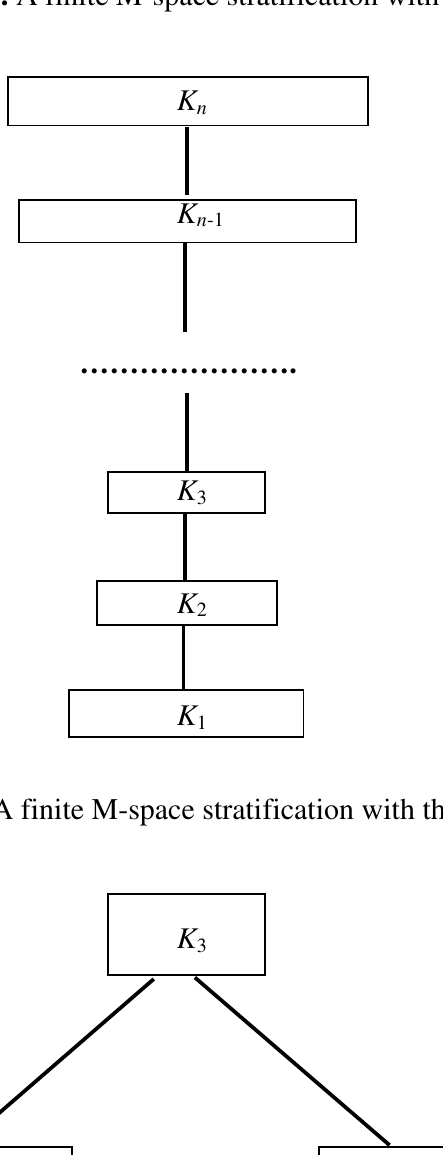
Figure 2. A finite M-space stratification with the linear topology.